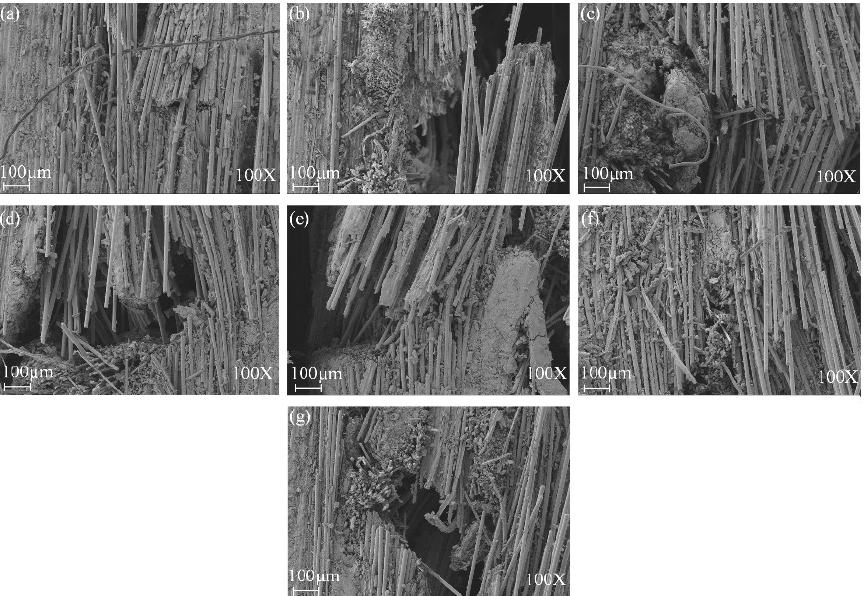
Figure 14. SEM images of impact specimens in seawater aged condition ( a ) GF ( b ) BF ( c ) GB1 ( d ) GB2 ( e ) GB3 ( f ) GB4 ( g ) GB5.